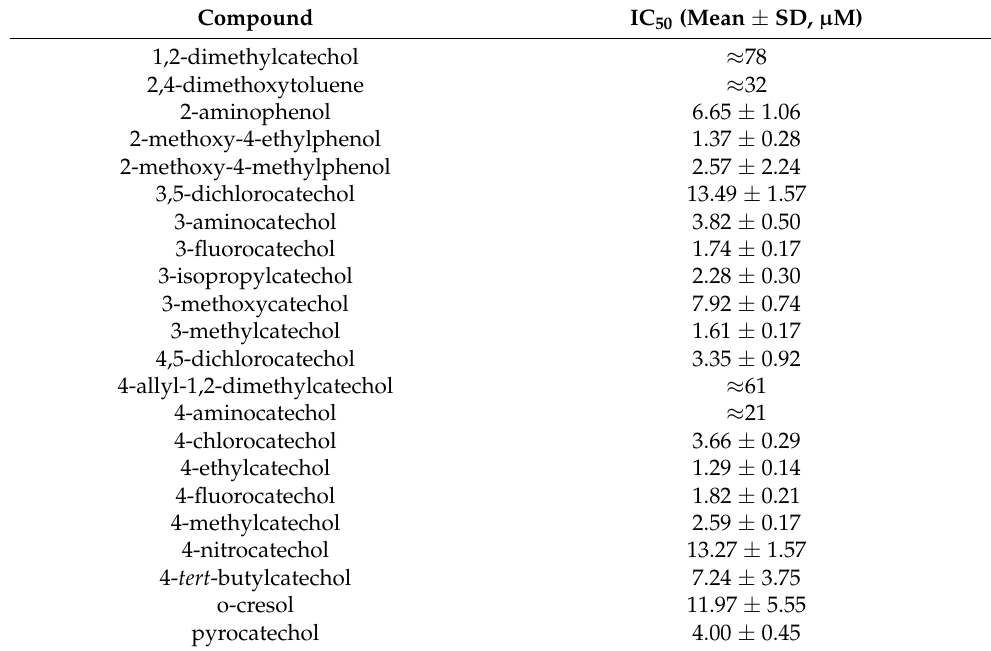
Table 1. IC 50 on Arachidonic Acid-induced Platelet Aggregation.